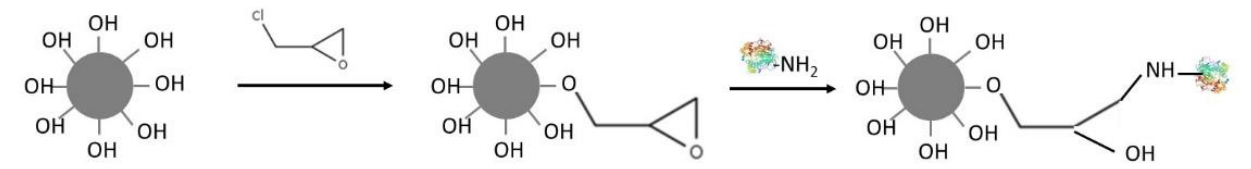
Figure 15. Possible mechanism of reaction for silica support with functional activating agents epichlorohydrin and